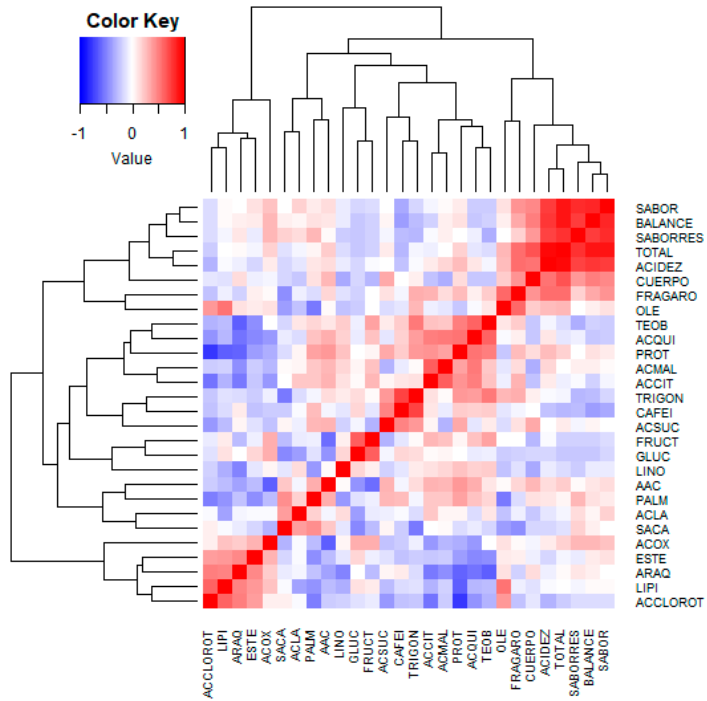
Figure 6. Heatmap of green coffee kernel chemical compounds and sensory